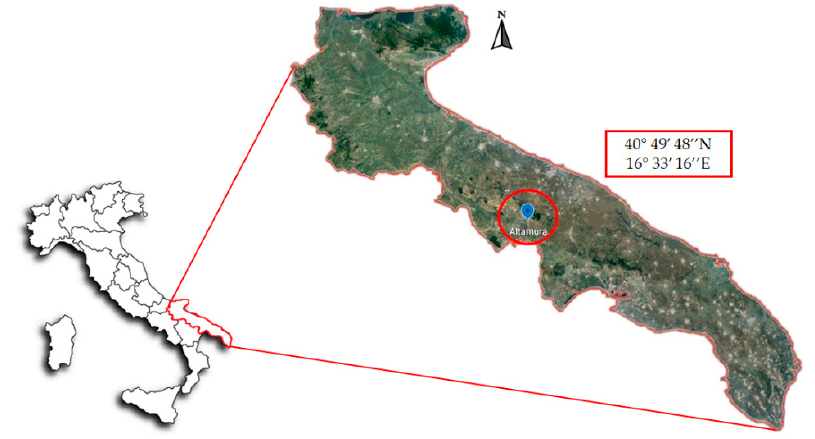
Figure 1. Location of the sampling site with geographic